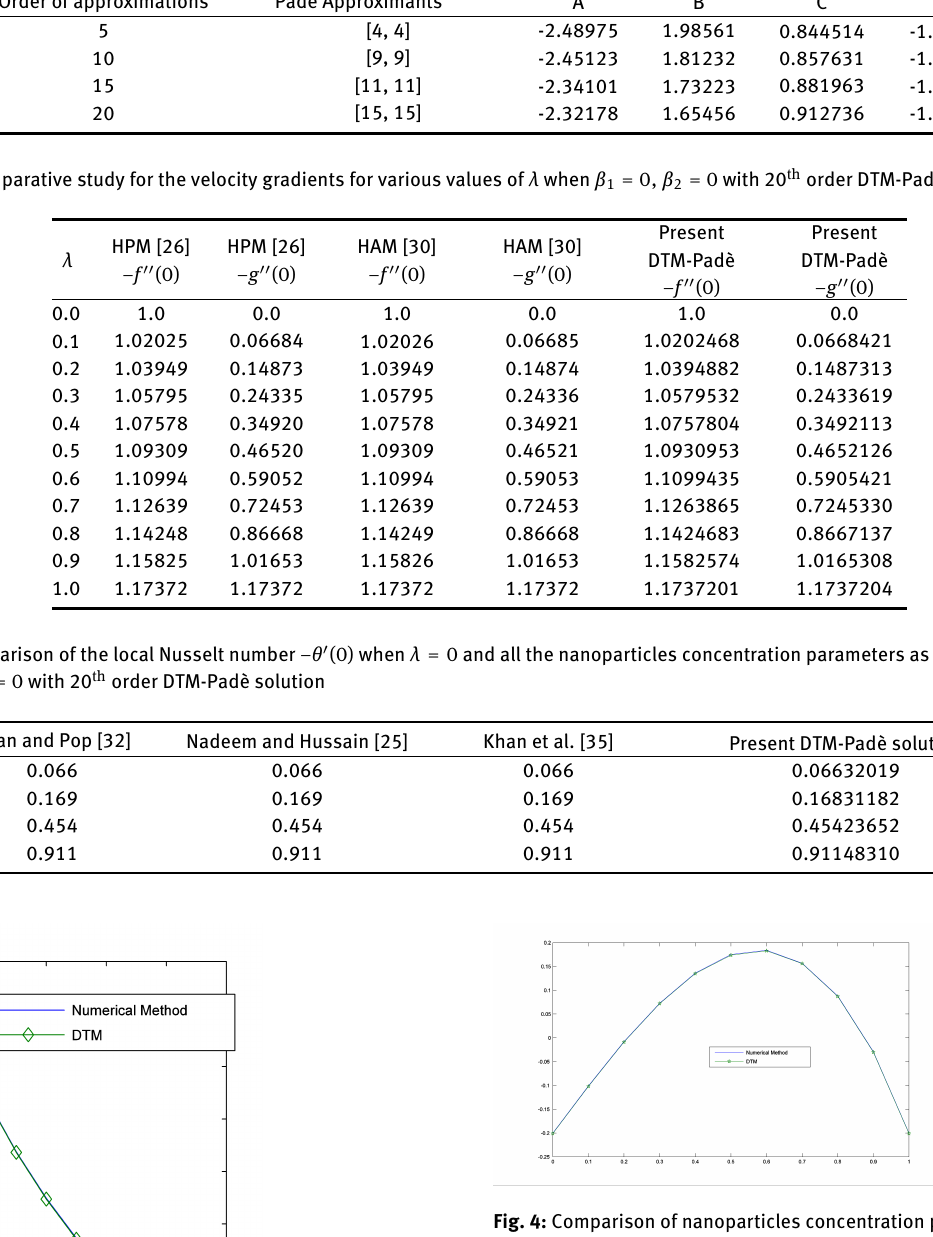
Order of approximations